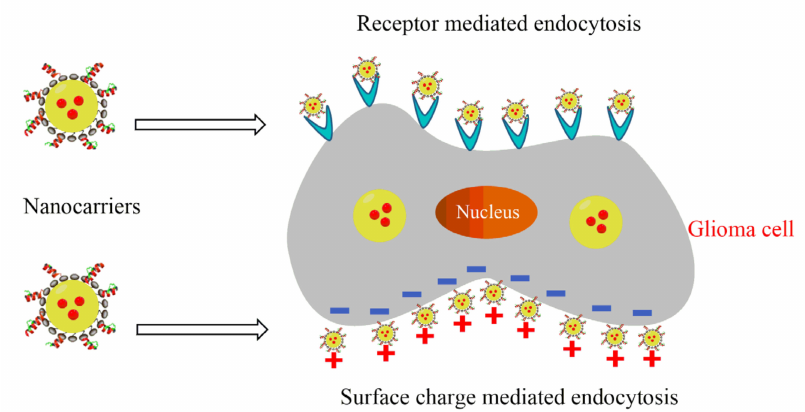
Figure 5. Schematic illustration of endocytosis by two mechanisms: receptor-mediated endocytosis and endocytosis by surface charge of nanoparticles, in glioma